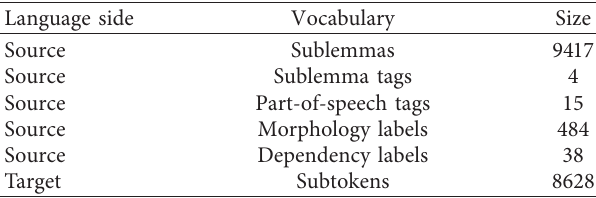
Table 5: Size of vocabulary in sublemma-based Transformer